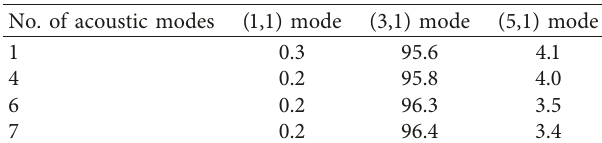
Table 6: Mode contribution at the (3,1) mode peak frequency ( κ � 0.2, ζ �